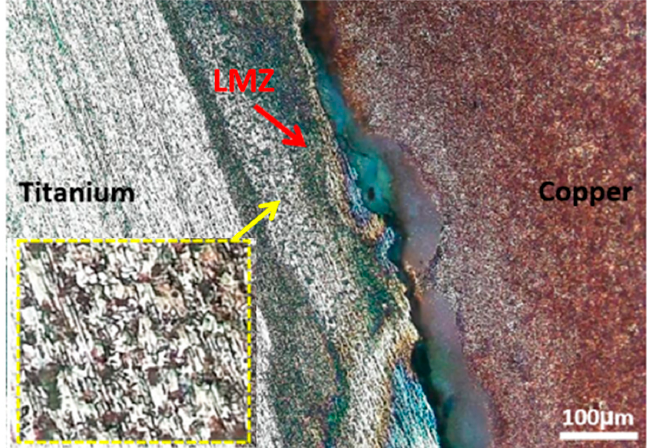
Figure 11. The plots of potentiodynamic polarization of Ti, Cu and weld interface immersed in 3.5 wt.% NaCl solution for 1 and 6 h.